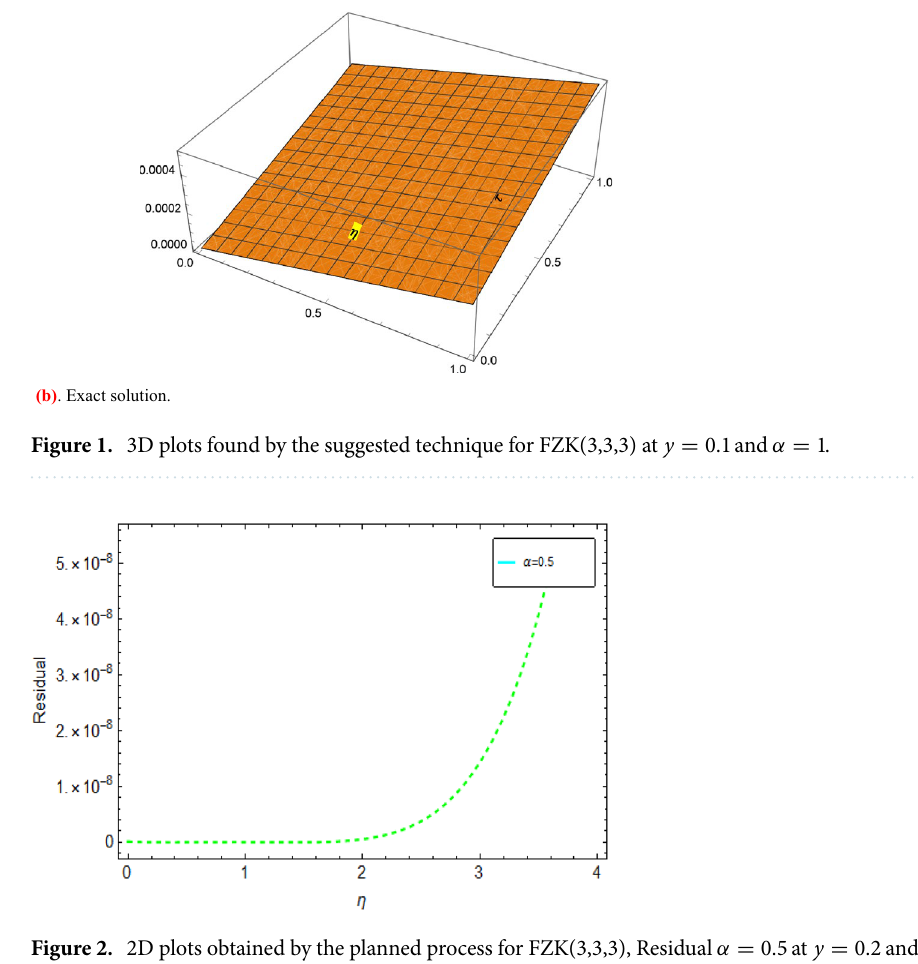
Figure 2. 2D plots obtained by the planned process for FZK(3,3,3), Residual α = 0.5 at y = 0.2 and τ =